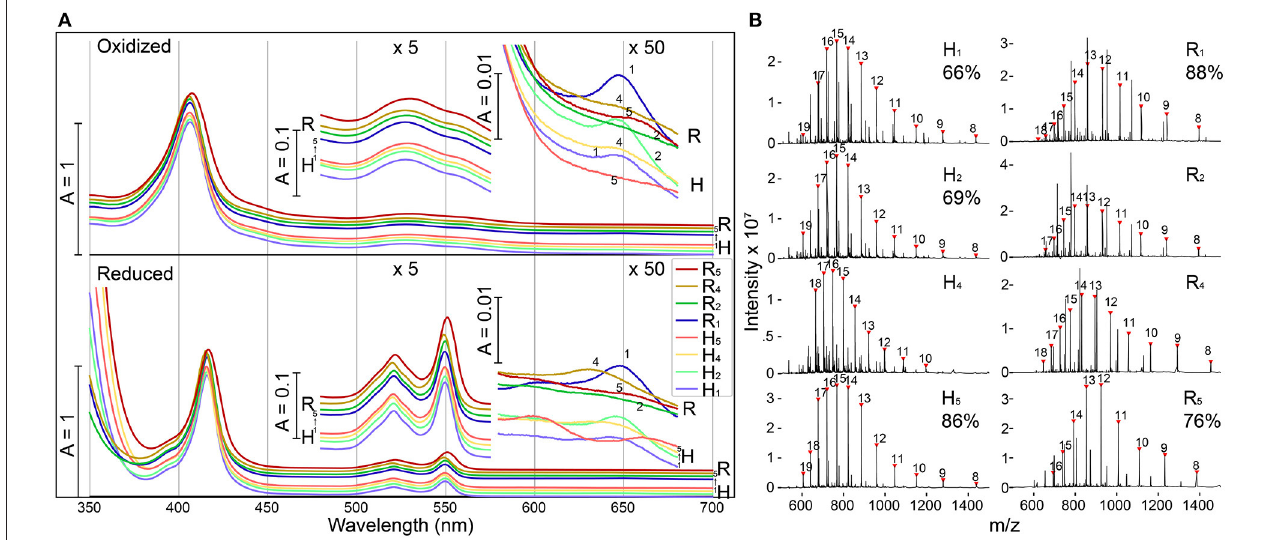
FIGURE 2 | Modified shell proteins contain redox-active hemes (A) UV-Vis spectra of purified shell-cytochromes under oxidizing (upper) or reducing (lower) conditions. Green region and red region also plotted with 5x or 50x amplification. (B) Protein mass spectrometry of purified shell-cytochromes. Expected holo -protein are marked with charge states in red triangles. The percentage of holo -protein in all full-length protein are labeled under the sample name (If available, see section Methods). See Supplementary Figure 3 for unlabeled